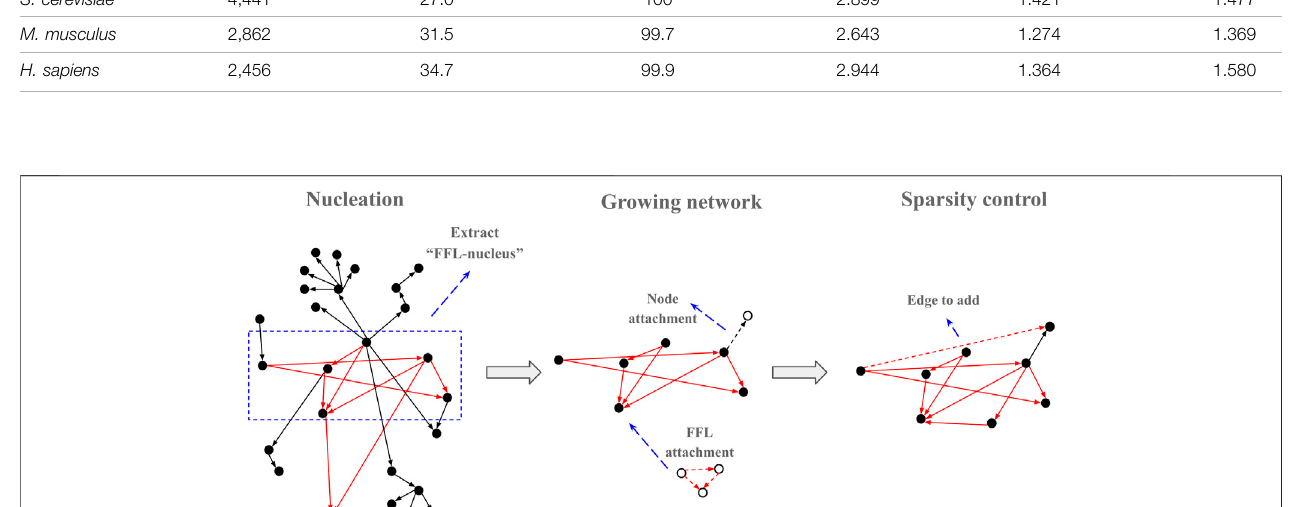
FIGURE 3 | Graphic outline of the FFLatt algorithm. It starts with selecting a seed from the input network, and then iteratively grows the nucleus until the required size is reached. Finally, the sparsity of the network is adjusted according to the sparsity level.